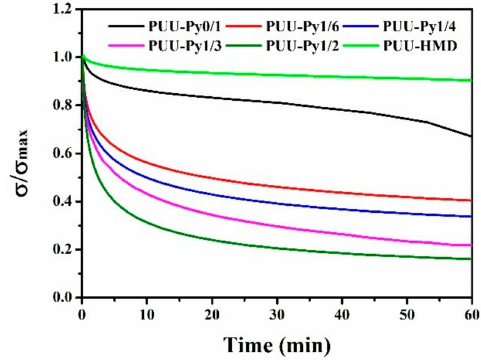
Figure 7. Relaxation of various PUU